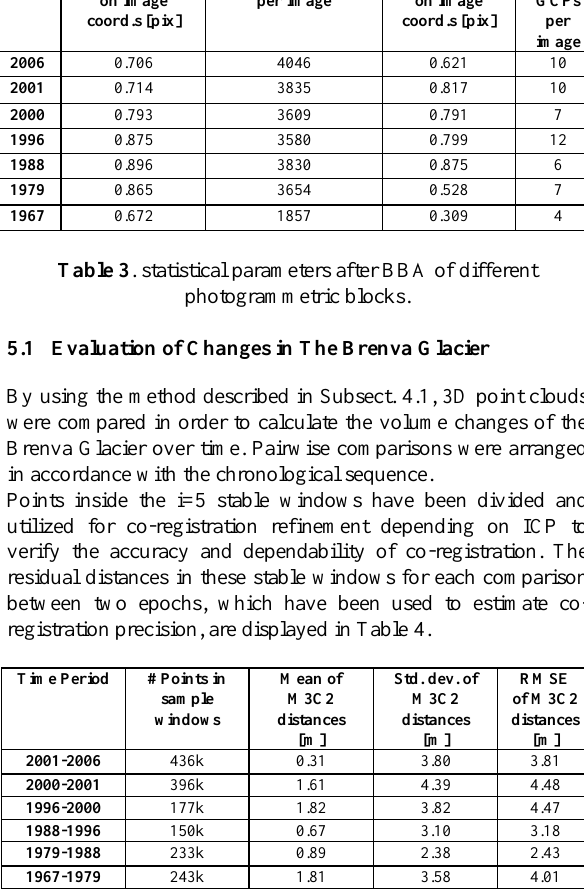
Table 4 . Residual co-registration errors in five sample windows of stable parts around Brenva Glacier.